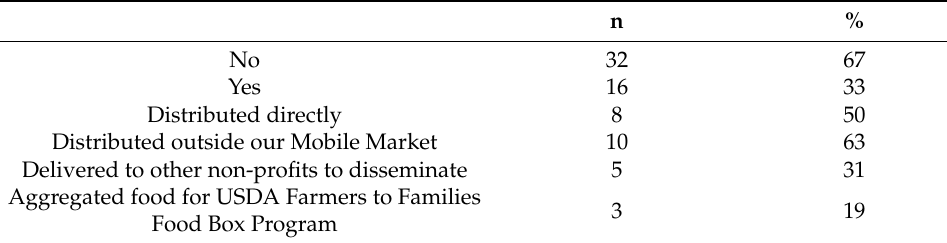
Table 10. USDA Farmers to Families Food Box Program